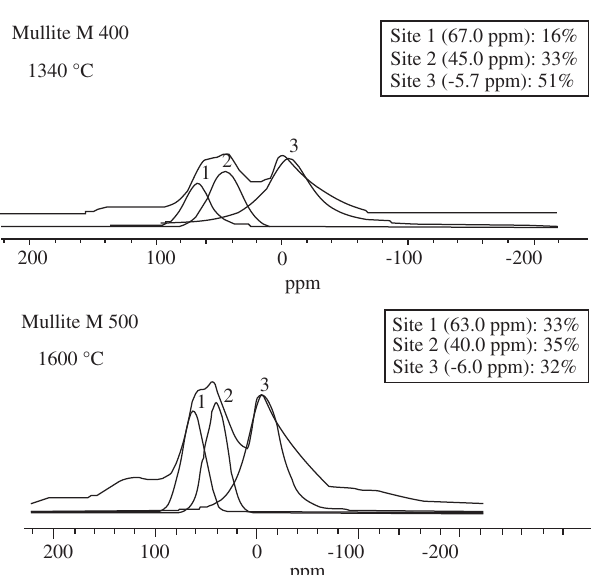
Figure 5. Experimental and deconvoluted 27 Al MAS NMR spectra of the M400 and M500